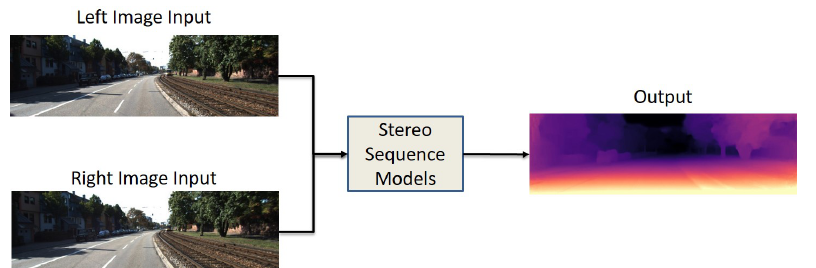
Figure 6. Data input/output structure of stereo sequence models. Stereo pairs of images as an input and single image